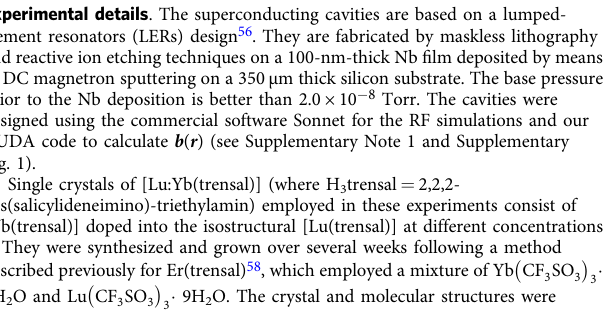
Fig. 1, the microwave magnetic fi eld created by the cavities is mostly perpendicular to the crystal anisotropy axis. The geometry of the setup is shown in Fig. 1c and Supplementary Fig. 3. The chip is connected through coaxial lines to a Vector Network Analyzer (VNA) with a measurement frequency bandwidth ranging from 10 MHz to 14 GHz. The device is then characterized by measuring the transmitted signal S 21 . Spin Hamiltonian . In our calculations, [Yb(trensal)] is described by the effective spin Hamiltonian: